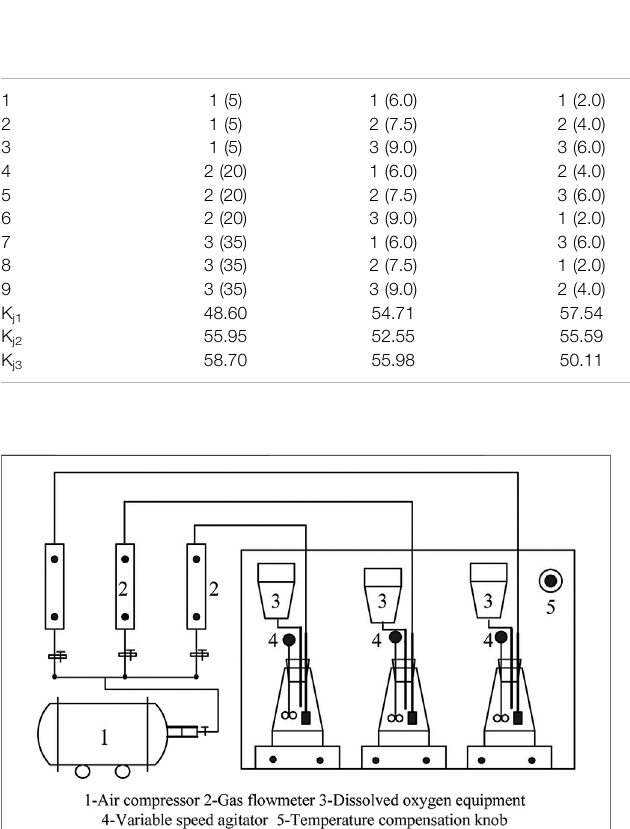
TABLE 1 | Statistics of the total nitrogen released from the sediments of the Dahekou Reservoir in the orthogonal experiment. Sequence number